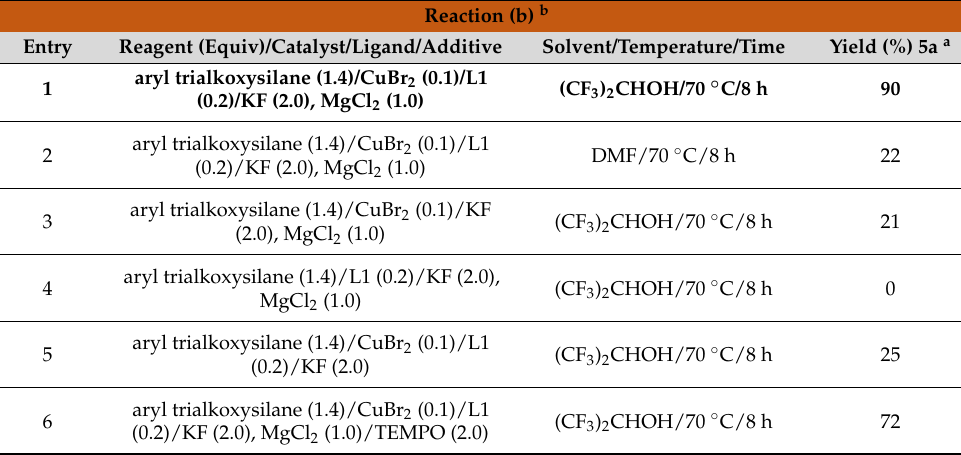
Table 2. Optimization of the reaction conditions for synthetic protocol